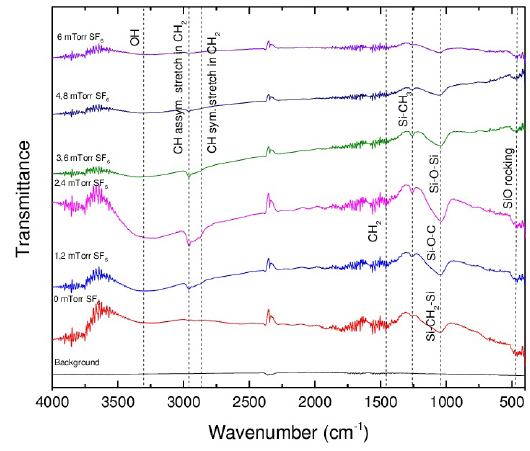
Figure 7. IRRAS spectra off the films deposited at different R